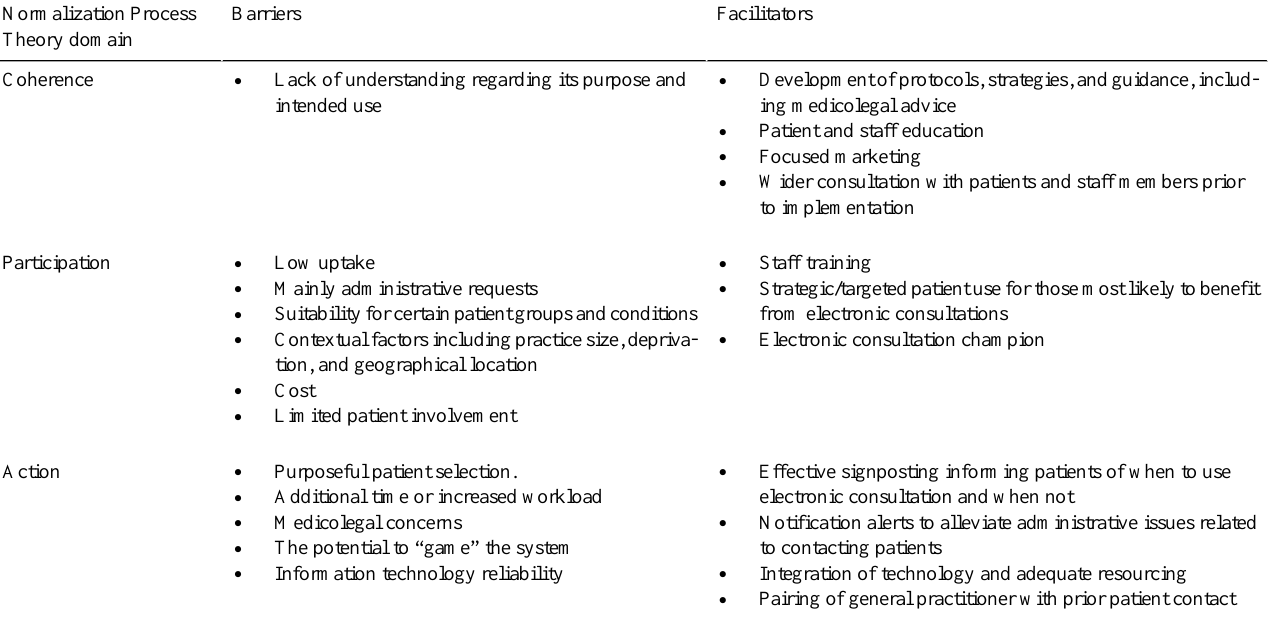
Table 2. Identified barriers and facilitators to electronic consultation implementation and